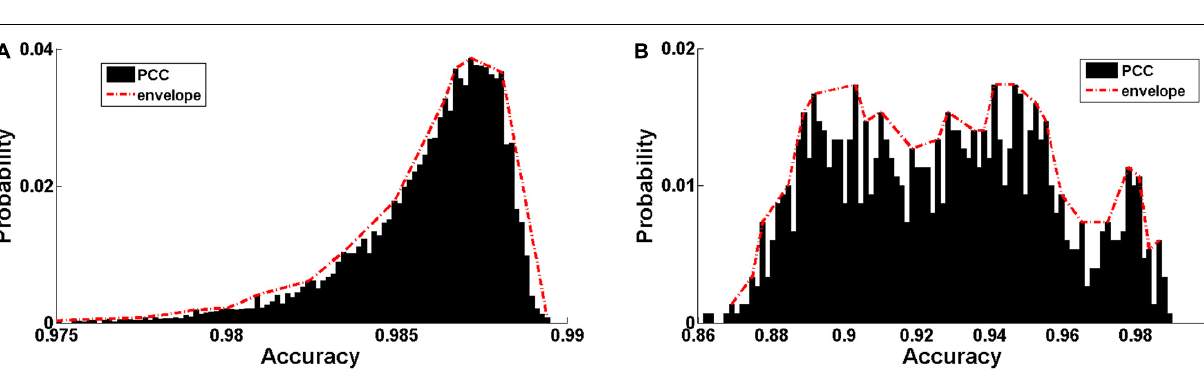
FIGURE 5 | Encoding performance of the trained DCAE model. (A) The distribution of Pearson correlation coefficients (PCC) between the input audio signals and reconstructed ones in the MagnaTagATune dataset and LibriSpeech Corpus. (B) The distribution of PCC in the auditory samples from the fMRI